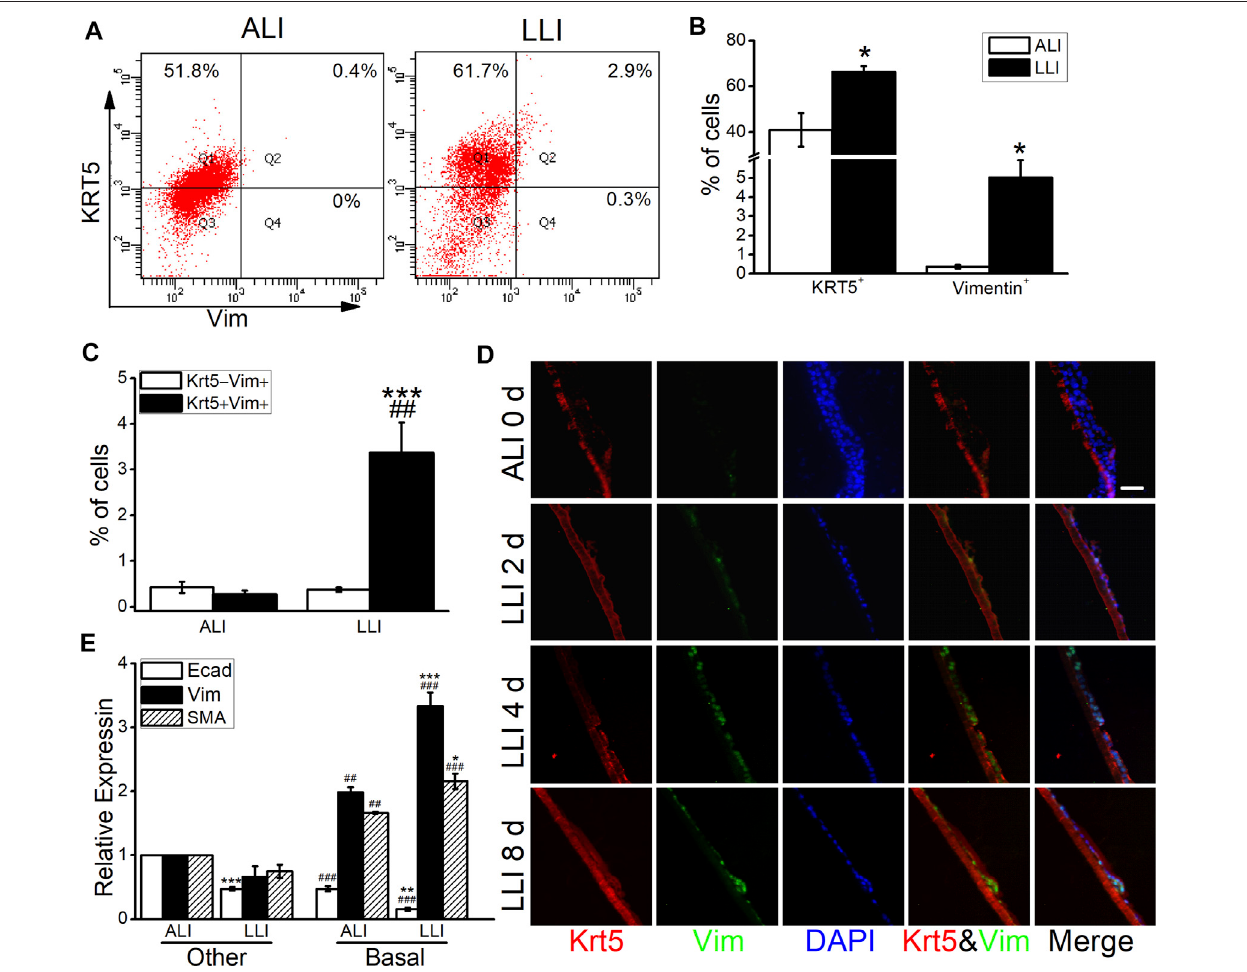
FIGURE 3 | EMT induced by hypoxia was mediated by basal cells. (A) Representative data of fl ow cytometry in the ALI and LLI groups and the cell ratios were labeled in the corresponding gates. (B) Vimentin and Krt5 positive cell ratios in the mode ofLLI culture. * p < .05, compared withALI group, n (cid:1) 3 – 4. (C) Krt5 positive cell ratioin Vimentin expressed cells. *** p < .001, compared with Krt5 + Vimentin − cells in LLI group, ## p < .01 compared with KRT5 + Vimentin + cells in ALI group, n (cid:1) 3 – 5. (D) Co-expression of Krt5 (red) and Vimentin (green) in MTECs after LLI culture. Scale bar (cid:1) 20 μ m. (E) Heterogeneously expressed EMT markers in different airway epithelial cell types after LLI culture. * p < .05, ** p < .01, *** p < .001, compared with the same cell type, ## p < .01, ### p < .001, compared with the other cells in ALI/LLI group. n (cid:1) 3. One-way ANOVA followed by Bonferroni ’ s test was used to analyze the difference of the means for signi fi